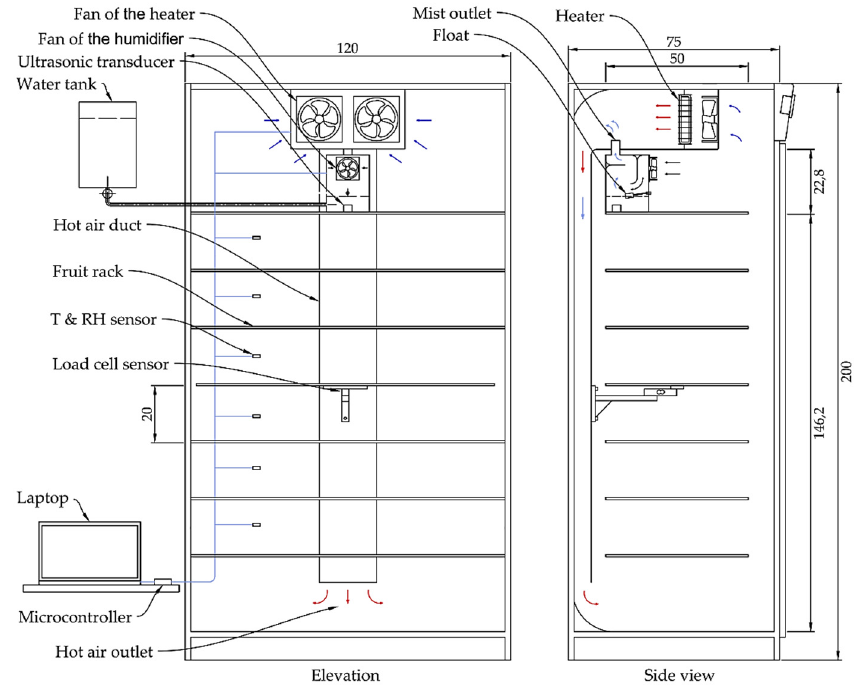
Figure 1. The elevation and side view of the sensor-based artificial ripening system’s main compo- nents, all dimensions in centimeters.